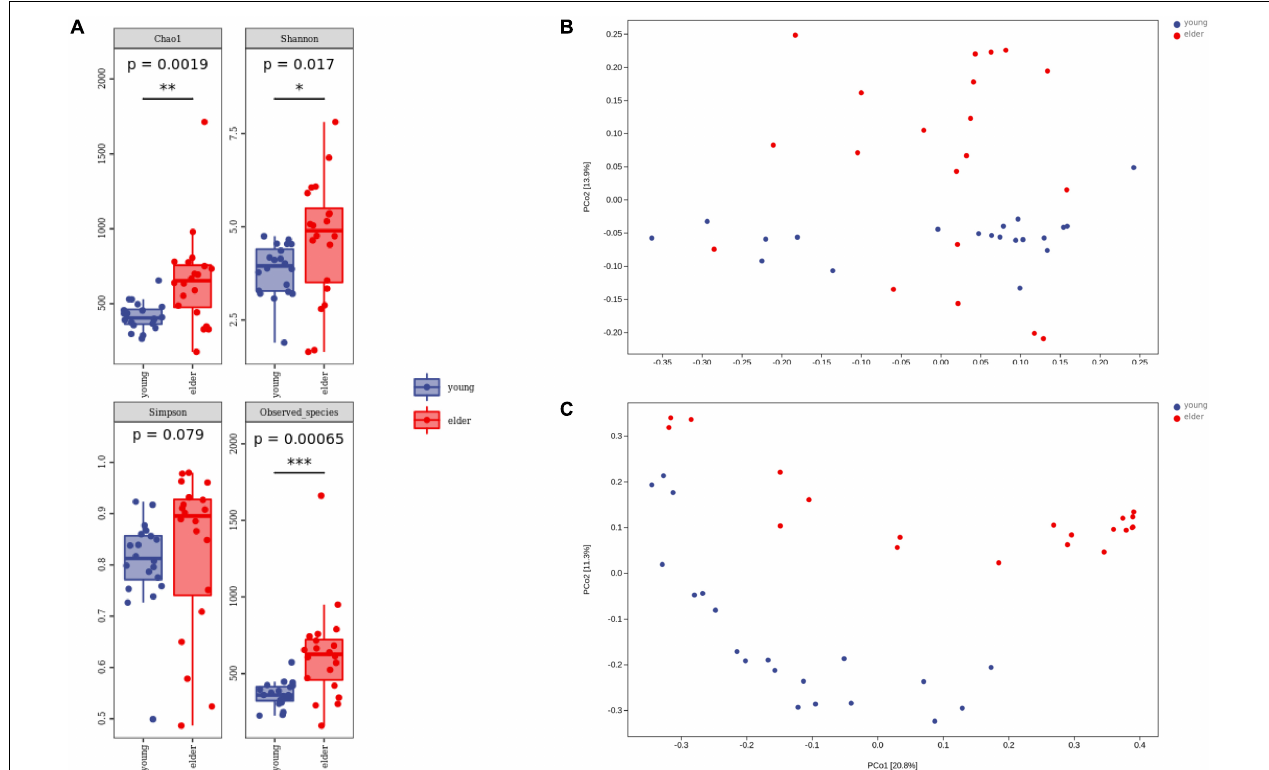
FIGURE 3 | Alpha diversity analysis and beta diversity analysis. Box plots of alpha diversity indices (A) are shown, including Chao1, Shannon, Simpson, and Observed_species. Weighted (B) and unweighted (C) beta diversity analyses are shown on the right side. ∗ p < 0.05, ∗∗ p < 0.01, and ∗∗∗ p <